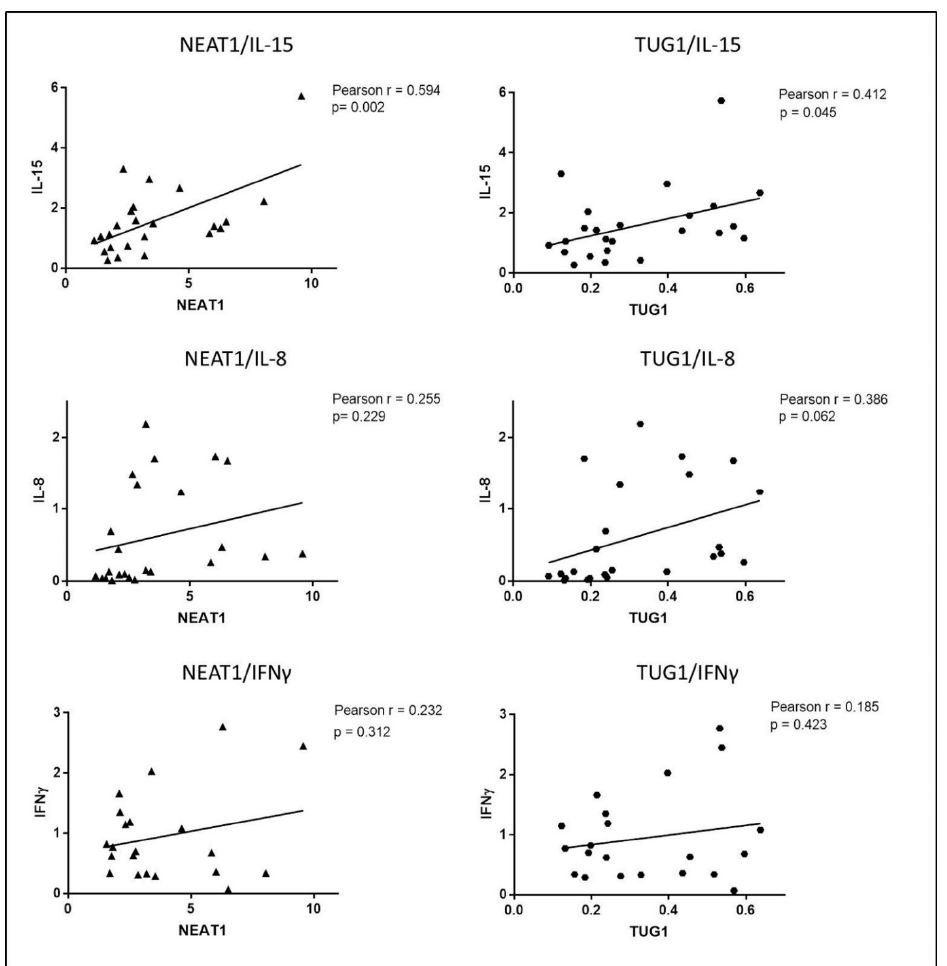
Figure 6. Pearson correlation analysis of mRNA expression levels of NEAT1 and TUG1 with IL-15, IL-8 and IFNγ in biopsies undergoing ex vivo experiments (HCs and GFD patients).